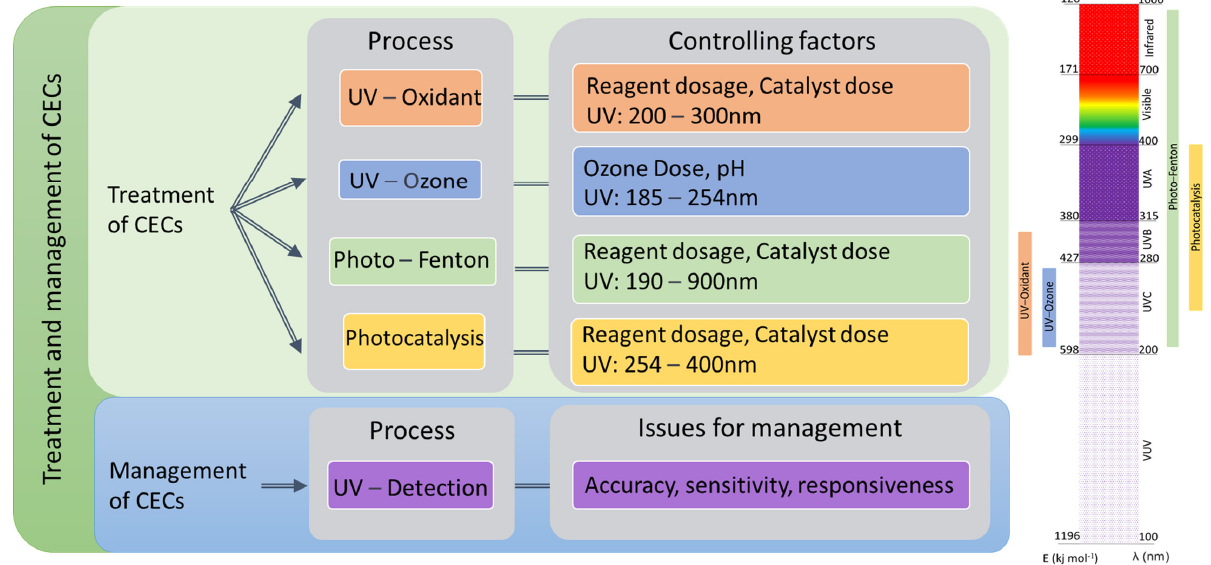
Figure 1. Overview of the treatment and management of CECs.